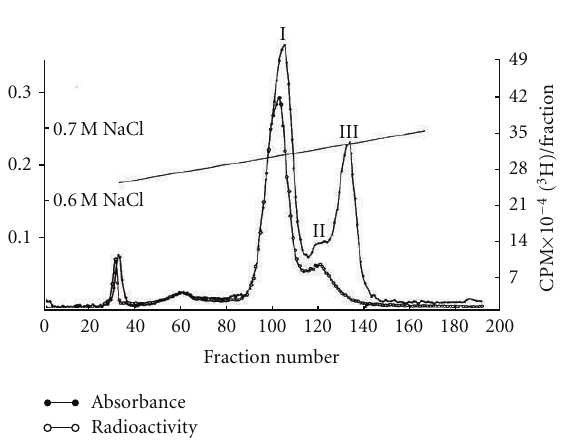
Figure 14: DEAE-Sephadex column chromatography of 4.5S RNA [38]. The 4.5S RNA from preparative gel electrophoresis was collected and chromatographed on a DEAE-Sephadex A-50 column. It was separated into 3 peaks but no radioactivity in 4.5S RNA III was detected, indicating the absence of accessible 2 (cid:2) -OH and 3 (cid:2) -OH in this molecule. The 4.5S RNA II may be the U6 RNA.